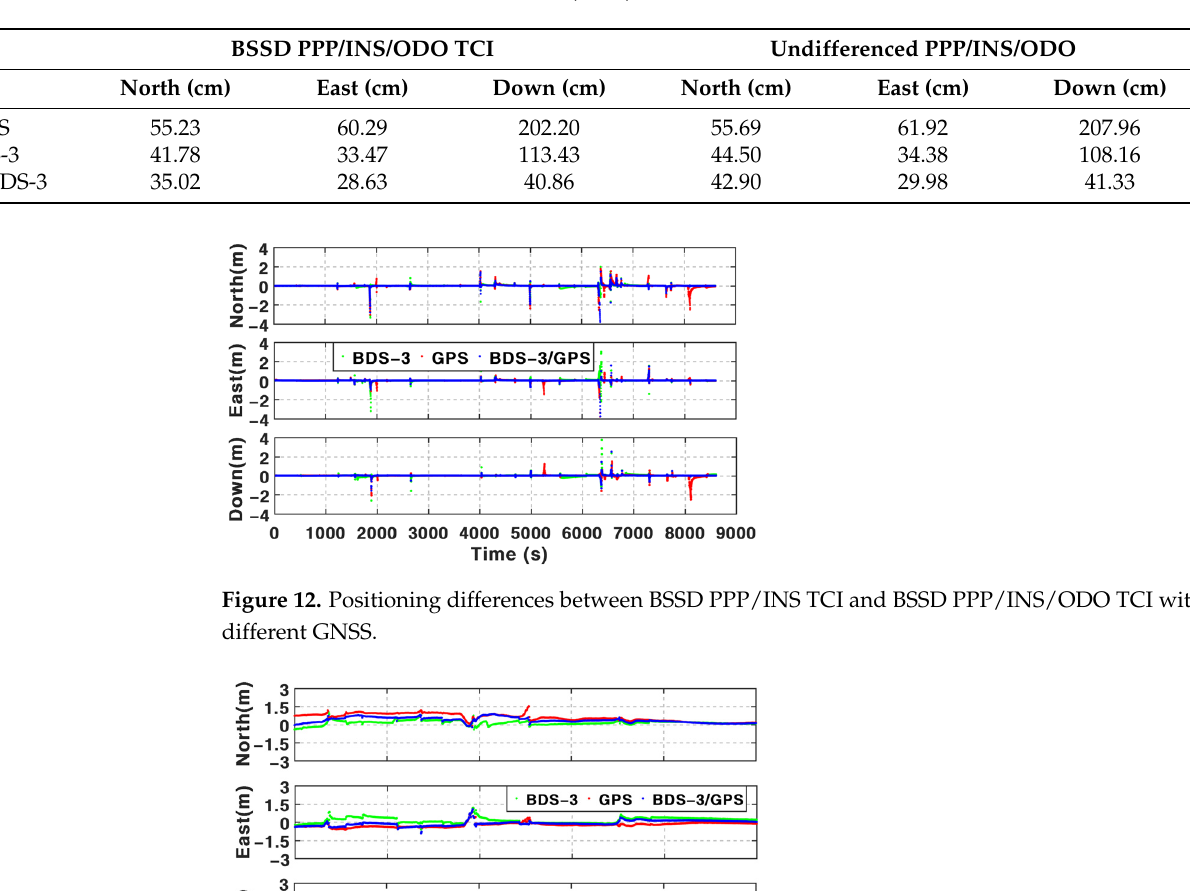
Figure 11. Positioning errors of BSSD PPP/INS/ODO TCI with different GNSS by using PPP-B2b corrections. Table 5. Position RMS of BSSD PPP/INS/ODO TCI with different GNSS.